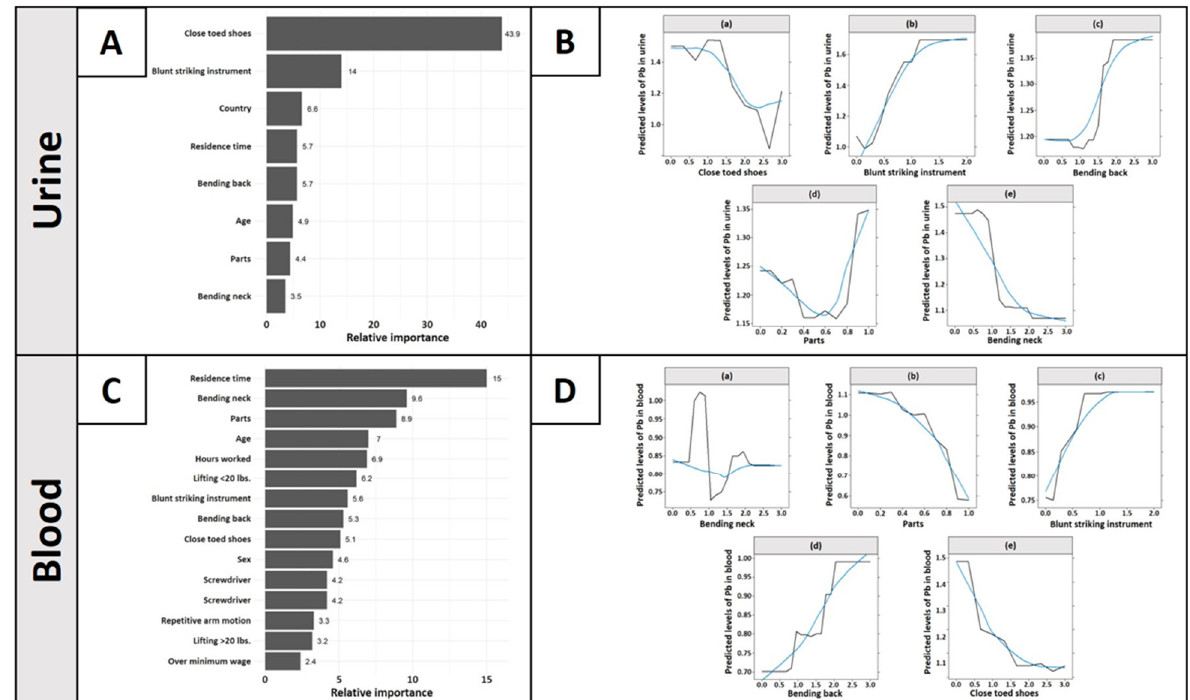
Figure 3. ( A ) The relative importance of demographic and job characteristics strongly predictive of log lead (Pb) concen- trations in urine. The displayed factors exceeded the randomness threshold of 100/45, or 2.22%. ( B ) Partial dependence plots for the five more influential job factors for log levels of Pb in urine in order of decreasing relative importance: (a) use of close toed shoes; (b) use of a blunt striking instrument; (c) the bending of the back; (d) dismantling of random parts; (e) the bending of the neck. The black line signifies the unsmoothed partial dependence plot, while the blue line signifies the smoothed partial dependence plot. ( C ) The relative importance of demographic and job factors strongly predictive of log Pb concentrations in blood. ( D ) Partial dependence plots for five of the influential job factors for log levels of Pb in blood in order of decreasing relative importance: (a) the bending of the neck; (b) the dismantling of random parts; (c) the use of a blunt striking instrument; (d) the bending of the back; (e) use of close toed shoes.